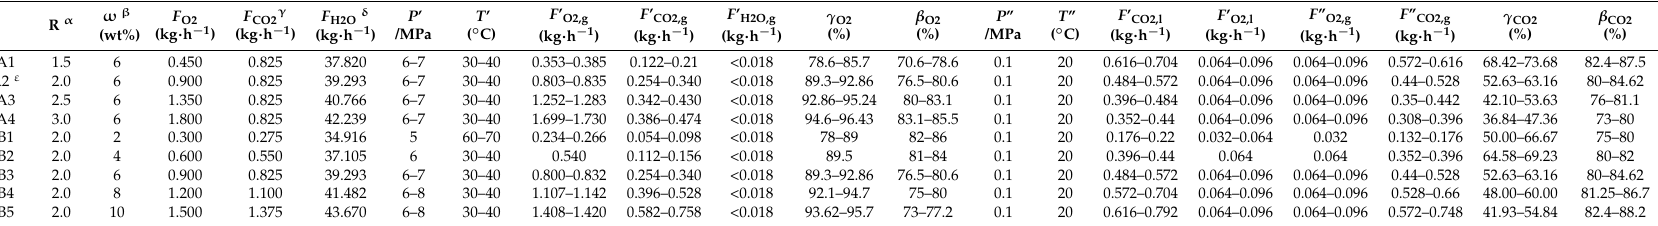
Table 2. Detailed parameters of the high-pressure and low-pressure